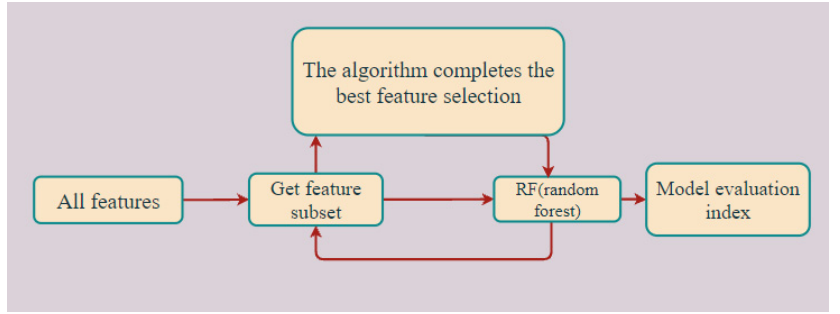
Figure 5. Process of